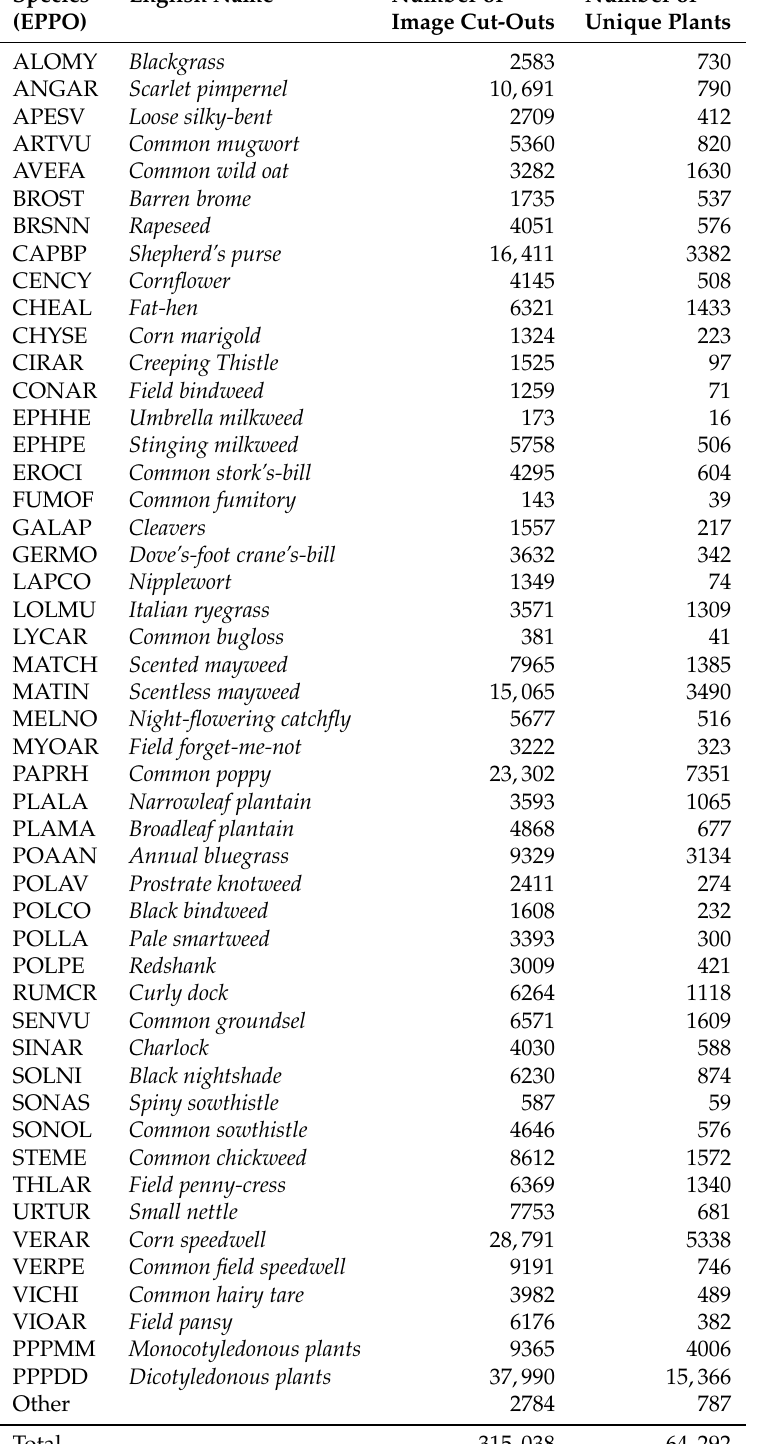
Table A2. Database content. Number of individual plant cut-outs and unique plants for each species in the dataset. The monocotyledons (PPPMM) and dicotyledon (PPPDD) categories cover cut-outs only annotated at these levels. The “Other” category cover cut-outs annotated at lower taxonomic levels than